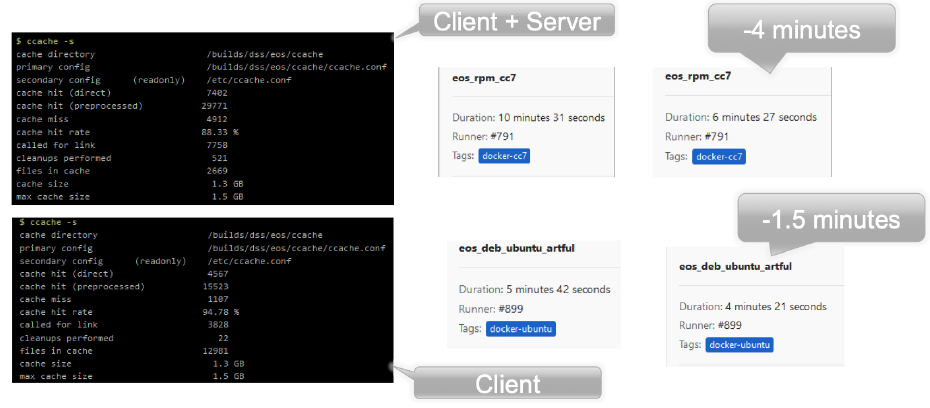
Figure 1. Compiler cache gain build